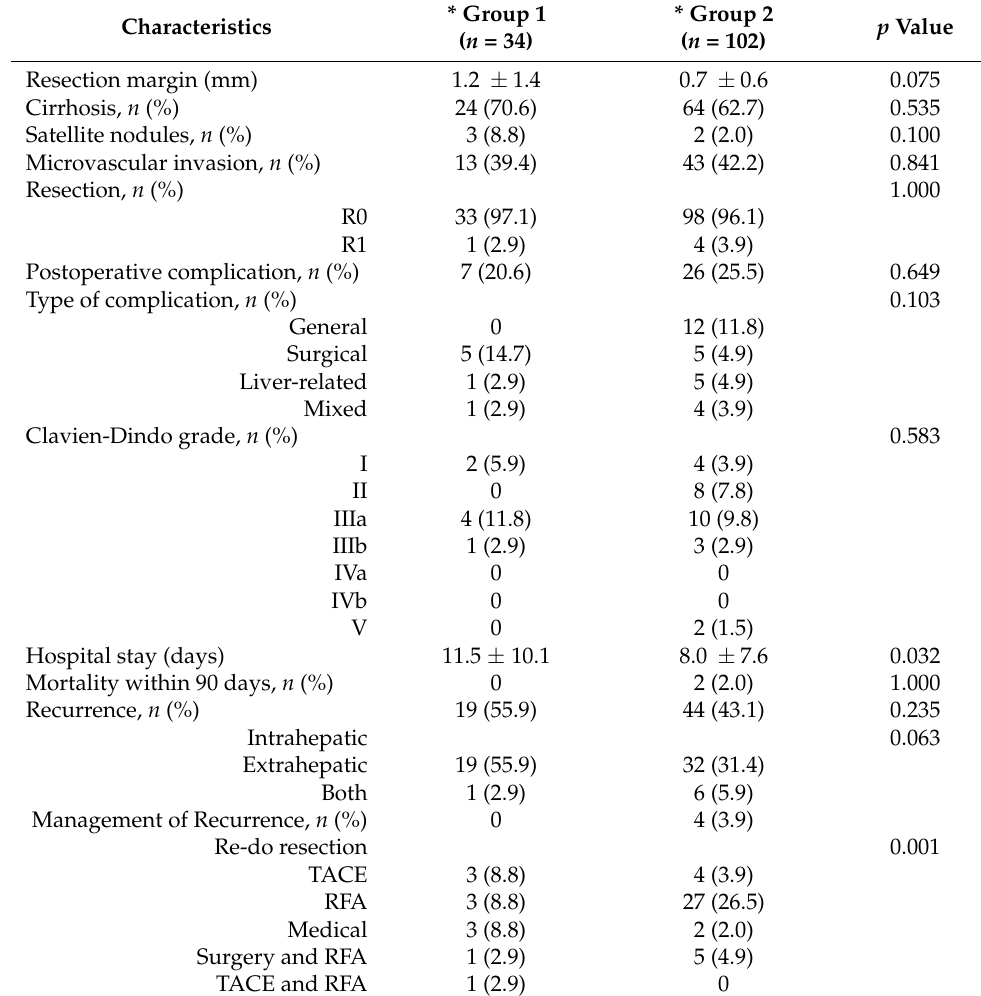
(Table 3), DFS or OS in two groups after matching ( p = 0.143) (Figures 1 and 2). Table 3. Pathologic and postoperative outcomes of laparoscopic liver resection for hepatocellular carcinoma in posterosuperior segments of the